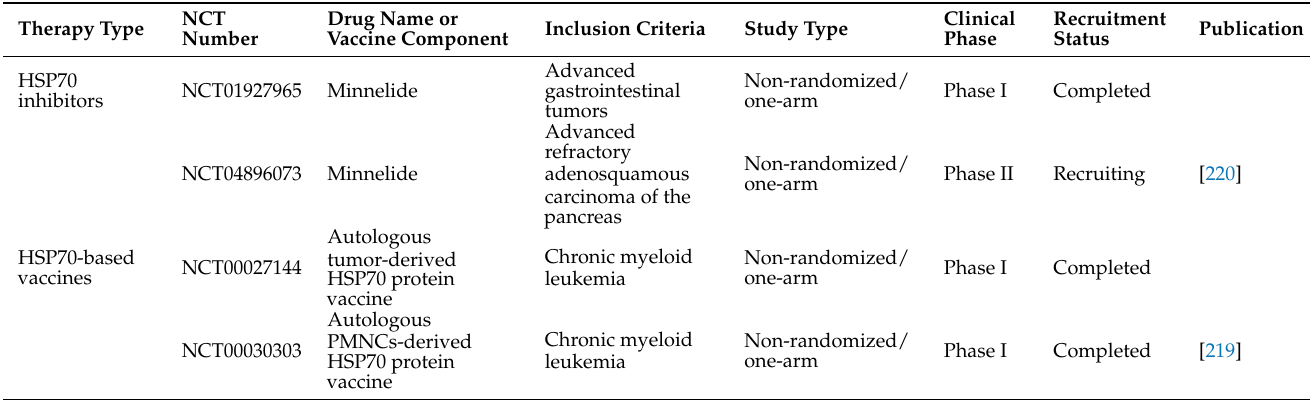
Table 3. HSP70-based cancer therapies in clinical